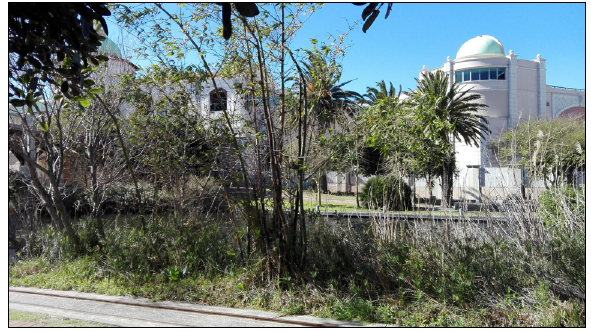
Bambusa balcooa at Canal Walk Shopping Centre, Western